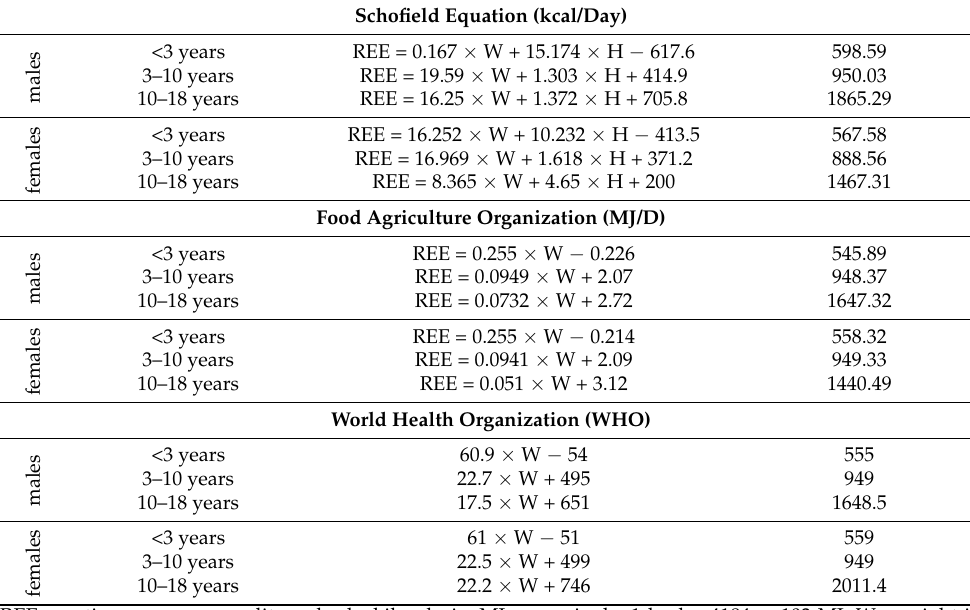
Table 1. Energy delivery calculation equations with model